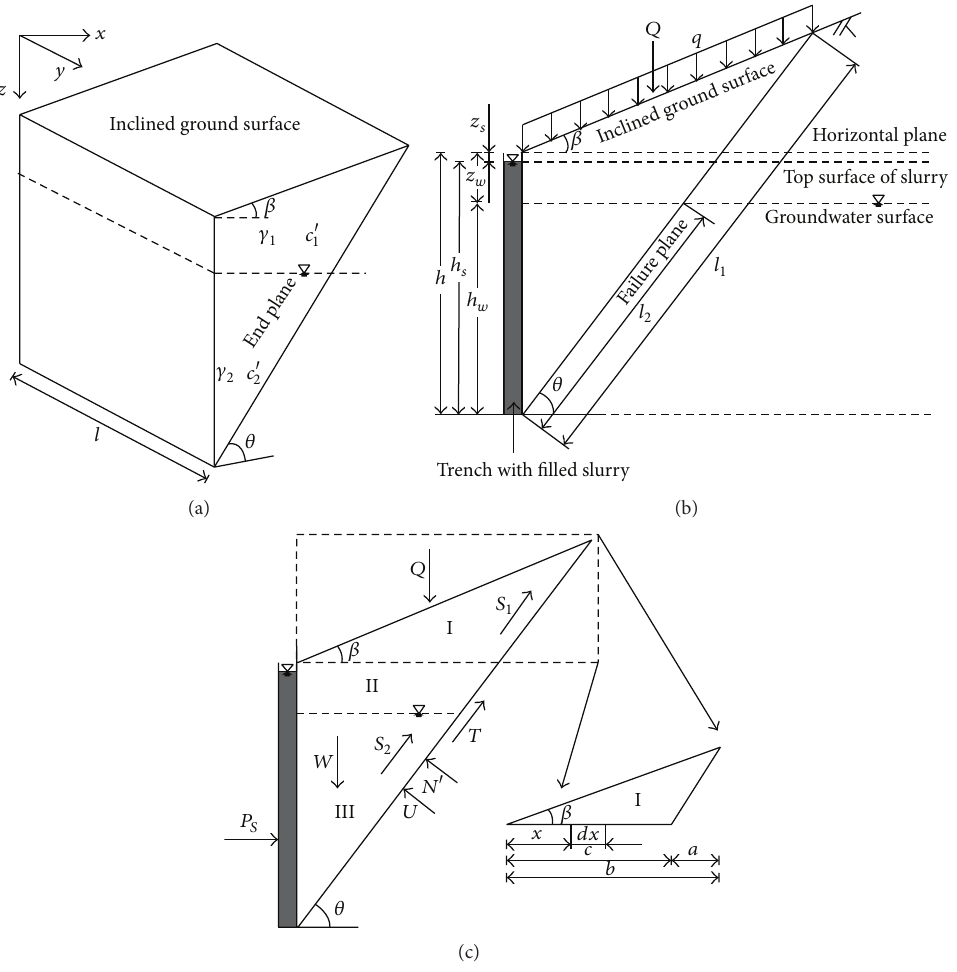
Figure 1: Three-dimensional failure wedge. (a) Schematic model of failure wedge, (b) definitions of geometric parameters, and (c) force